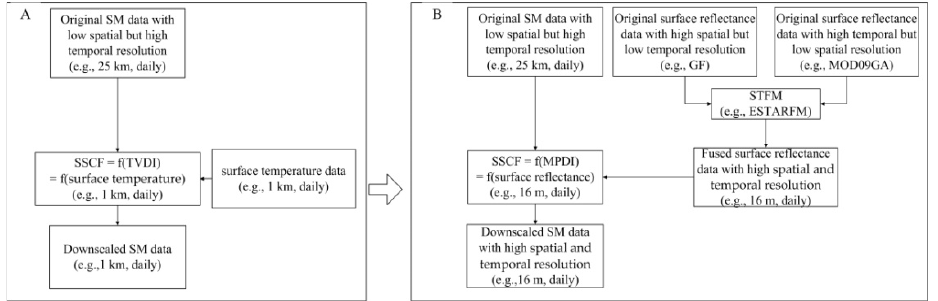
Figure 1. Overview comparisons between the traditional spatially downscaling method with surface temperature data as auxiliary parameters ( A ) and the proposed spatially downscaling method with fused surface reflectance data as auxiliary parameters ( B ).